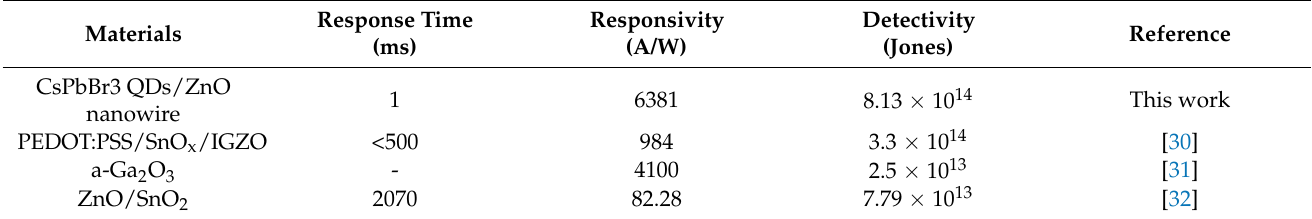
Table 1. Contrasting this research with other phototransistors described in the literature.